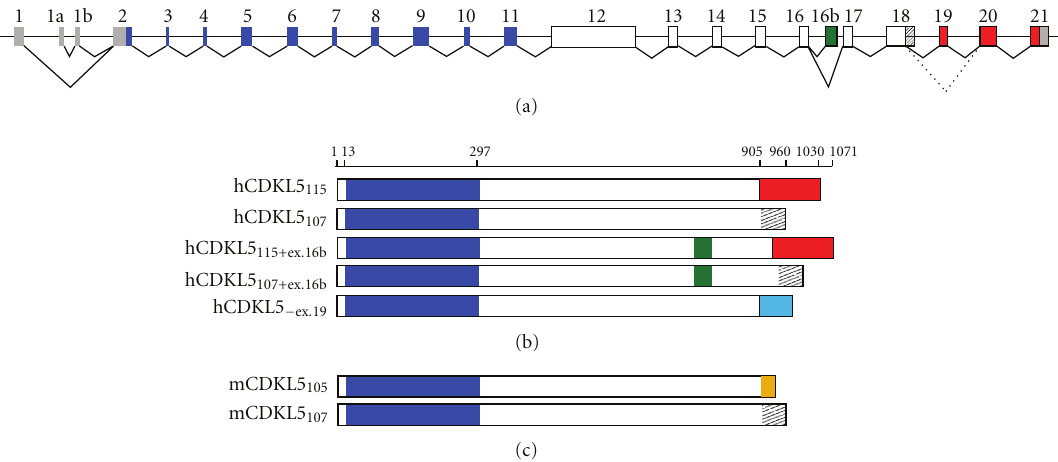
Figure 1: The genomic structure of CDKL5 and its splice variants. (a) The human CDKL5 gene with nontranslated sequences in grey and exons encoding the catalytic domain in blue. Exons encoding the common C-terminal region appear in white, whereas isoform-specific sequences are shown in red, green, and as hatched. (b) hCDKL5 protein isoforms di ff ering in the C-terminal region. CDKL5 115 [22] contains the primate-specific exons 19–21. In CDKL5 107 [3], intron 18 is retained. The inclusion of exon 16b would generate CDKL5 115+ex . 16b and/or CDKL5 107+ex . 16b [21, 23]. hCDKL5 − ex19 is a hypothetical splice variant in which exon 19 is excluded generating an alternative C-terminus (light blue; personal communication Limprasert.) (c) The murine CDKL5 isoforms. mCDKL5 105 harbors a distinct C-terminal region encoded by a mouse-specific exon 19 (orange). As in humans, the retention of intron 18 generates the common CDKL5 107 isoform